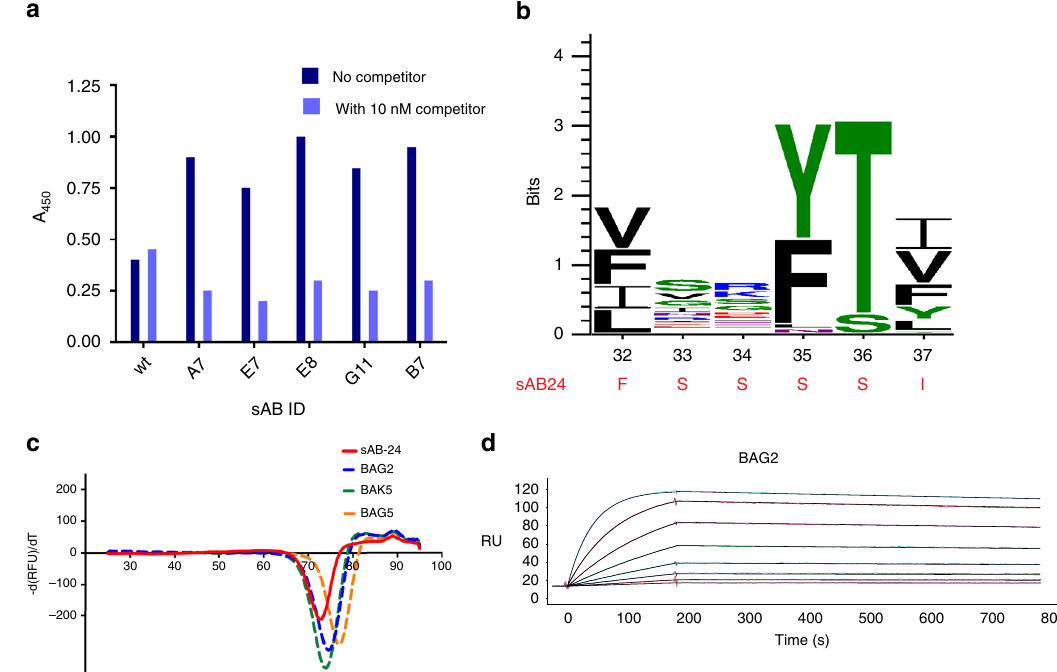
Fig. 3 Characterization of the af fi nity-matured variants. a Competitive phage ELISA shows that the representative af fi nity-matured variants have a stronger ELISA signal (dark blue bar) and better competition ratio (light blue bar) than the wt sAB24 indicating a higher af fi nity compared to wt sAB. b WebLogo plot of the af fi nity-matured variants show that the positions 35, 36 in CDR-H1 are biased in aromatic (F/Y) and polar (S/T) aa residues. The CDR-H1 sequence of the wt sAB24 is highlighted in red. c DSF data show that the melting temperature of the wt and the af fi nity-matured variants are comparable. d SPR sensograms depicting kinetics of binding of BAG2 with BRIL. The sensograms show a slow rate of